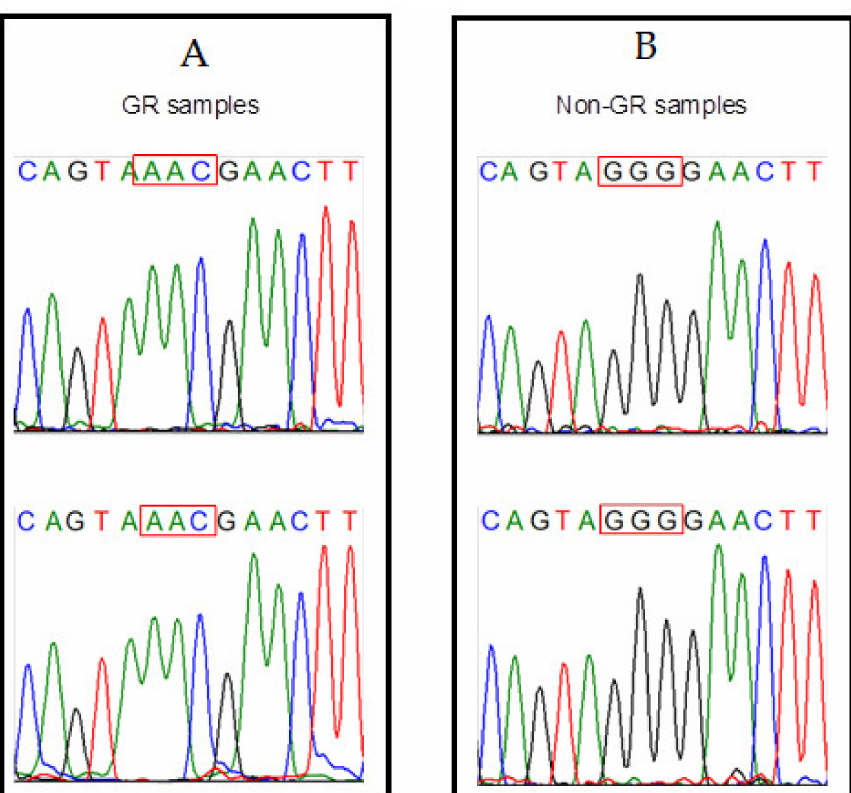
Figure 4. Traces obtained from four Sanger sequencing reactions of randomly selected samples predicted to belong to the GR samples (( A ), n = 2) and non-GR samples (( B ), n = 2).